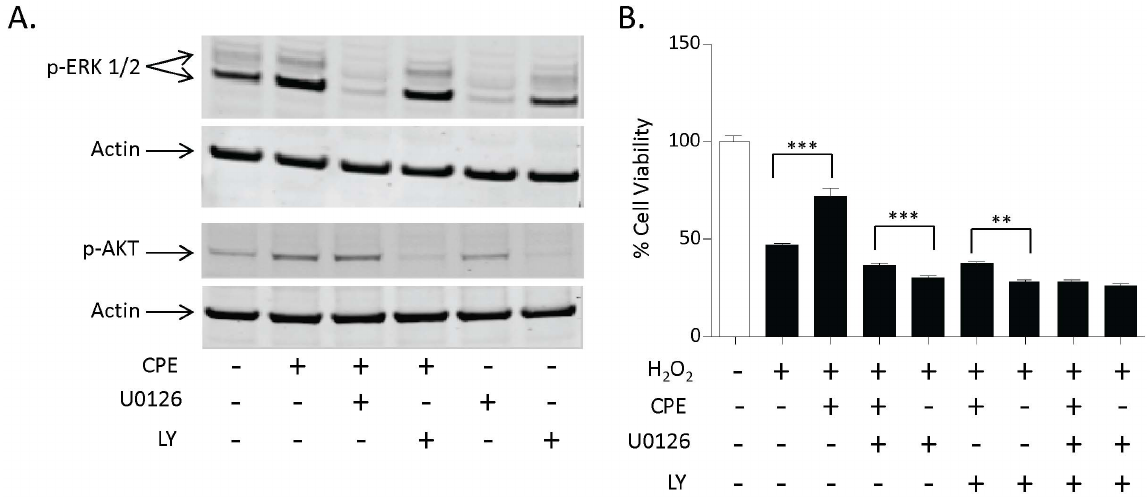
Figure 5. Both ERK and AKT signaling pathways are required for the neuroprotective effect of CPE. A) Western blot analysis showing that the CPE induced phosphorylation of ERK and AKT in primary cultured rat hippocampal neurons is blocked by U0126 and LY294002, respectively. B) Bar graphs showing WST activity, indicative of cell viability, of hippocampal neurons treated with and without H 2 O 2 in the continued presence or absence of CPE and kinase inhibitors. Note that the neuroprotective effect of CPE is blocked by U0126 and LY294002 in primary cultured hippocampal neurons. Also note that maximal effects were observed when both inhibitors were used together, suggesting that ERK and AKT signaling pathways work in parallel to mediate the neuroprotective effect of CPE (t test, n=5, ***p , 0.001, **p ,